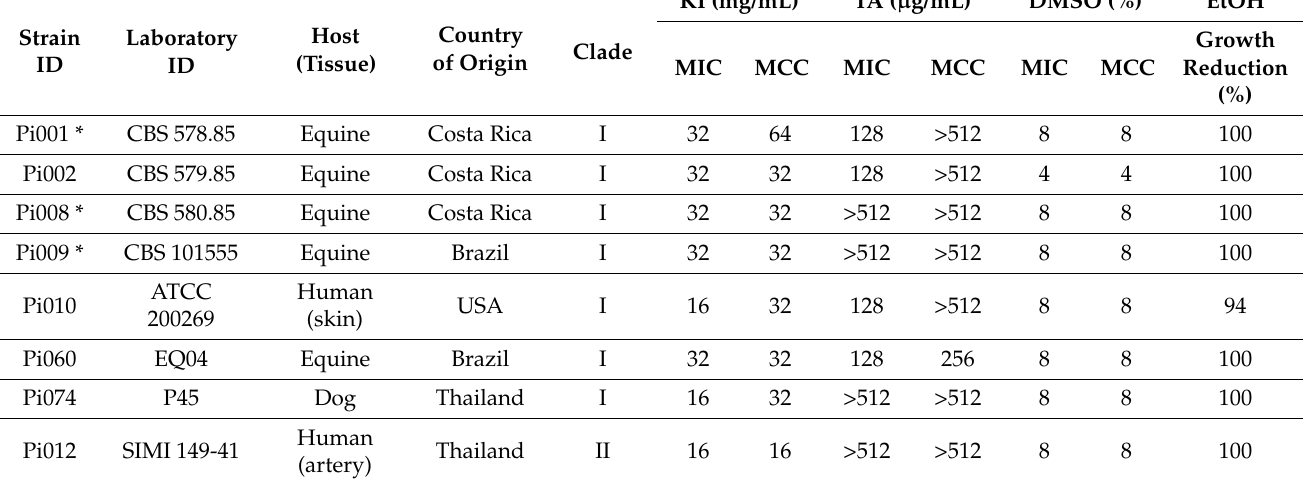
Table 1. Drug susceptibility analyses (i.e., determining minimal inhibitory (MIC) and cidal (MCC) concentrations and percent growth reduction) of potassium iodide (KI), triamcinolone acetonide (TA), dimethyl sulfoxide (DMSO), and ethanol (EtOH) tested against 29 P. insidiosum isolates. The 10 P. insidiosum isolates (indicated by an asterisk) were selected to test each chemical with